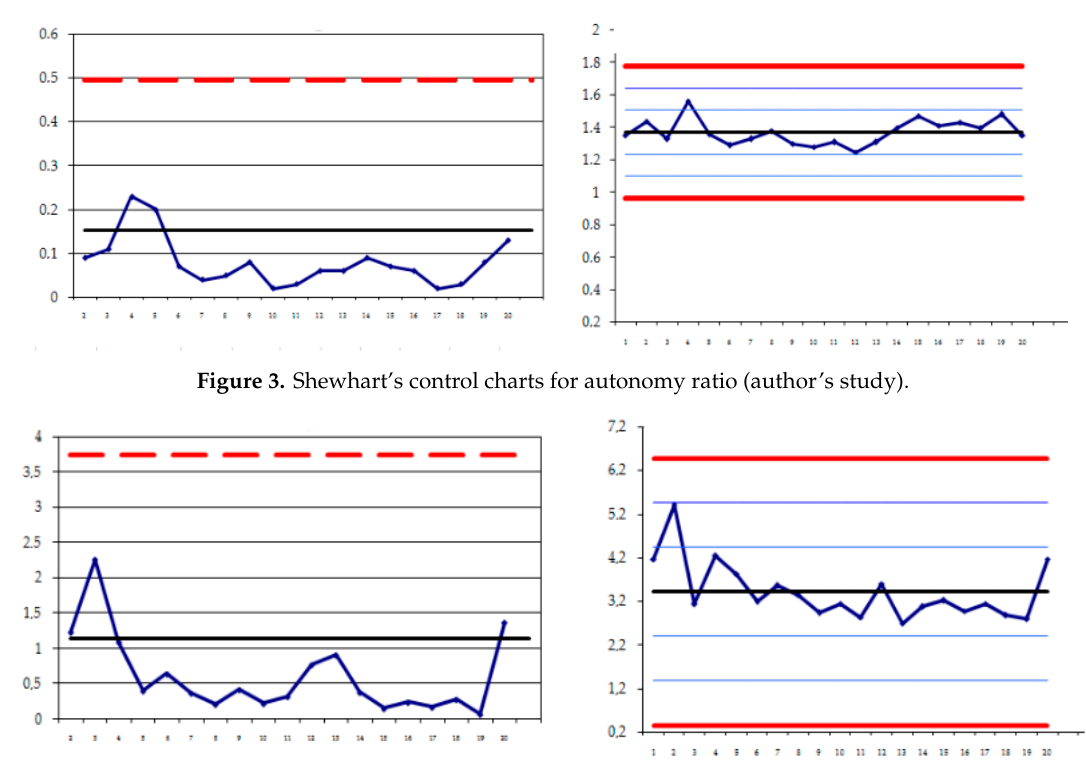
Figure 4. Shewhart’s control charts for seasonal ratio (author’s study).